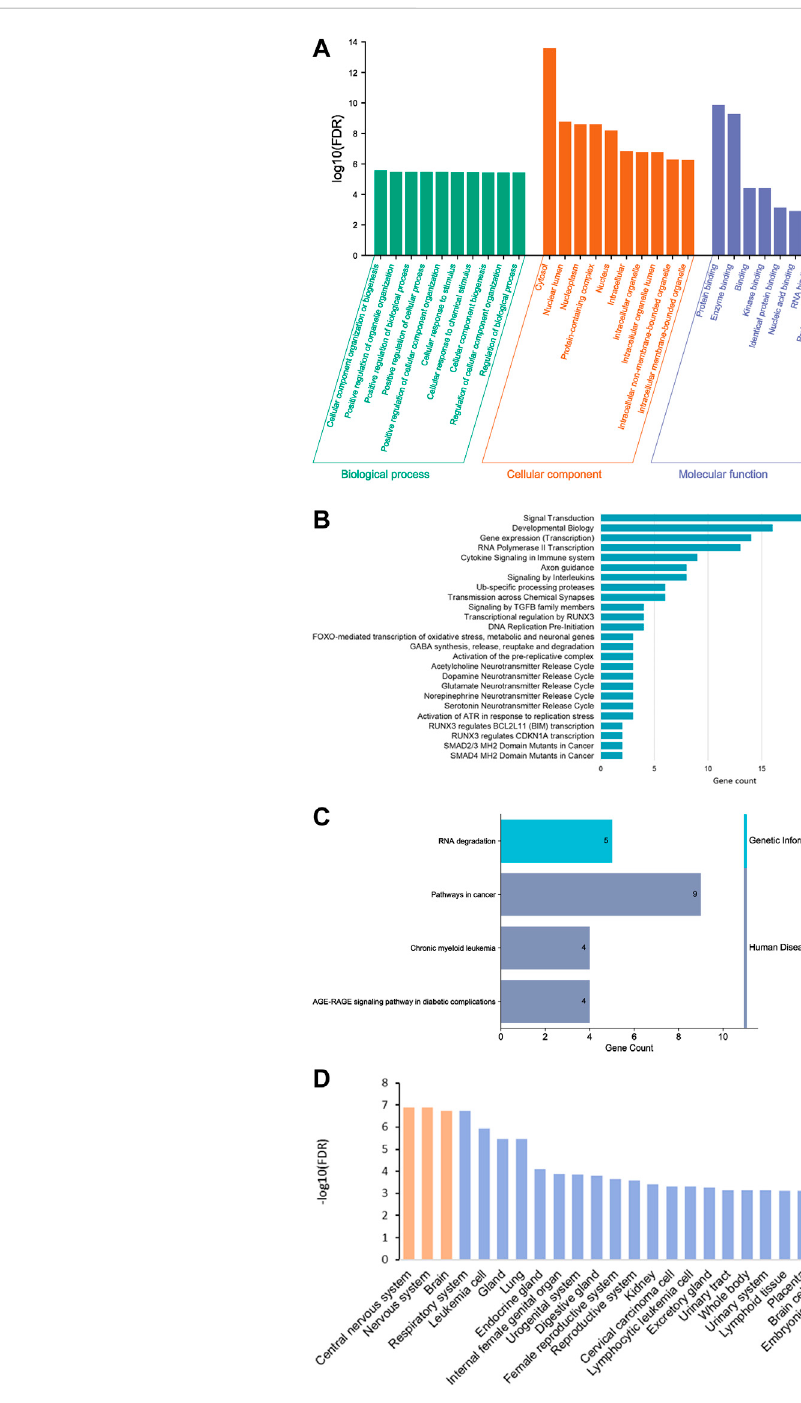
FIGURE 4 Geneontology(GO)functionalanalysishistogram (A) ,barplotofReactome (B) andKEGGpathway enrichmentanalysis (C) andenrichedtissues (D) .